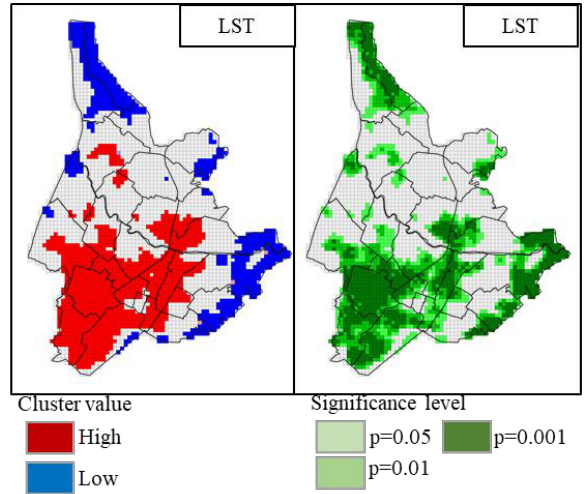
Figure 9. Univariate Local Moran’s I cluster and significance maps of Mandaue City